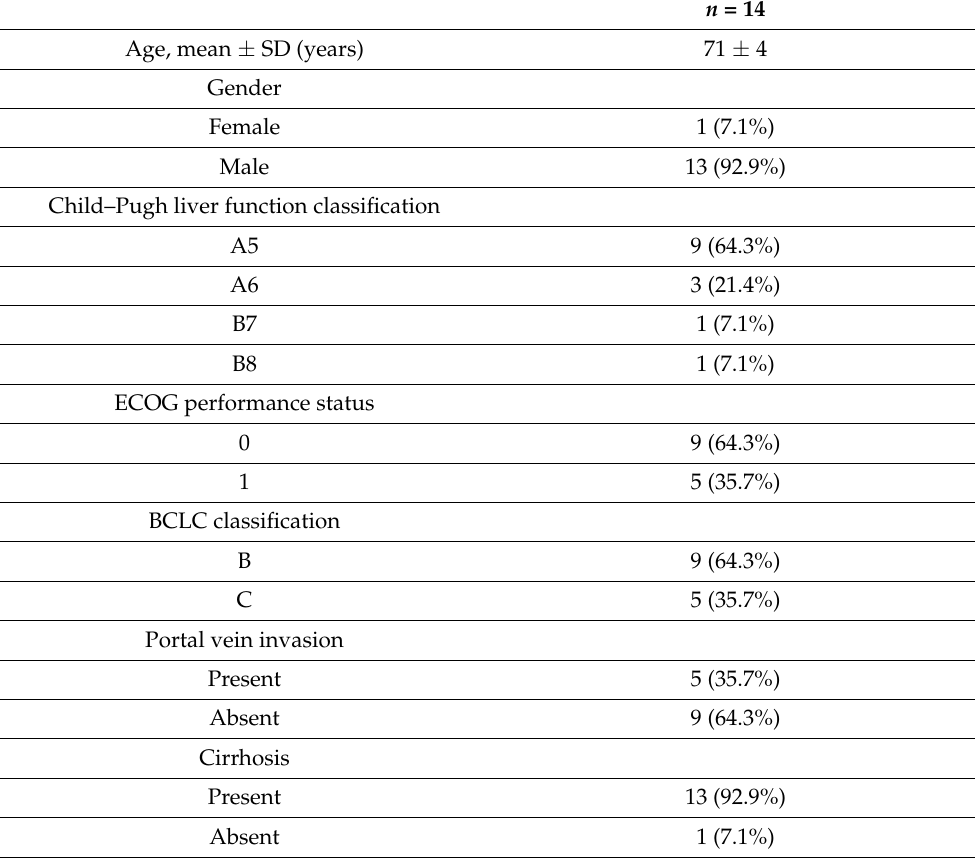
Table 1. Baseline patient